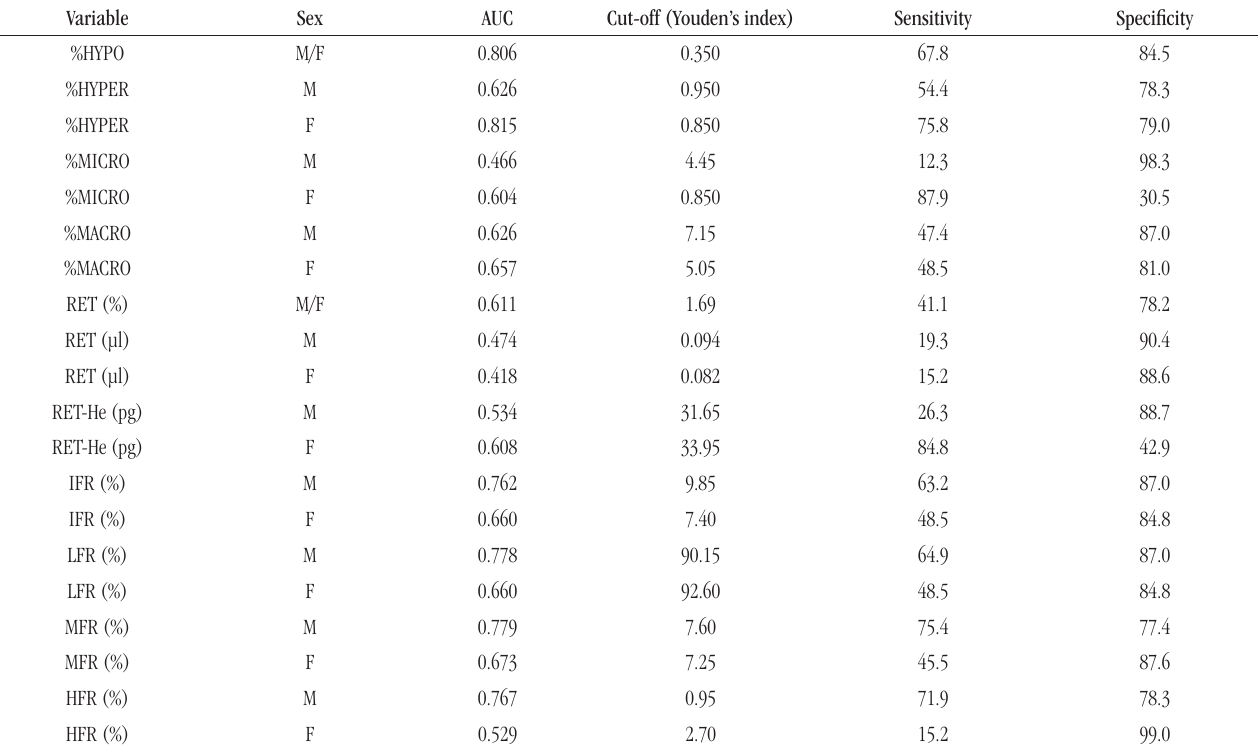
taBLE 3 − ROC curve, cutoff, sensitivity and